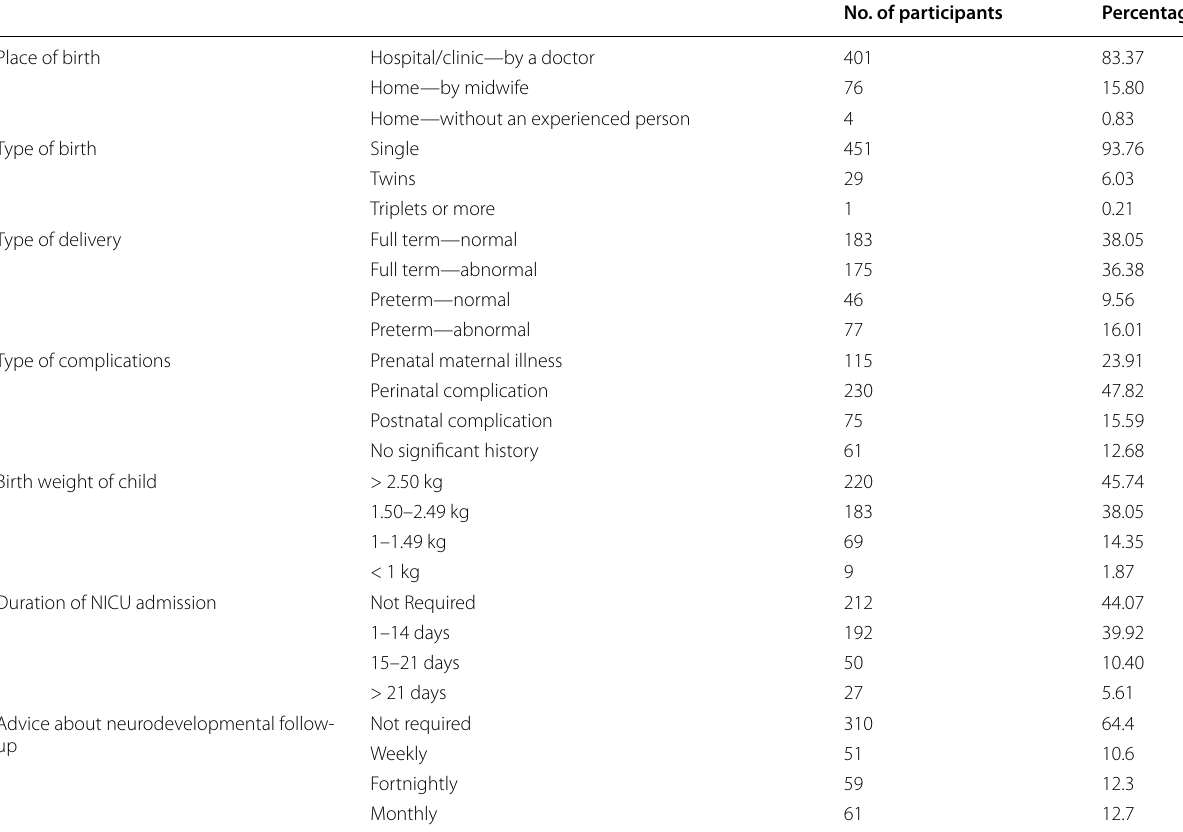
Table 5 Details of birth history of the child